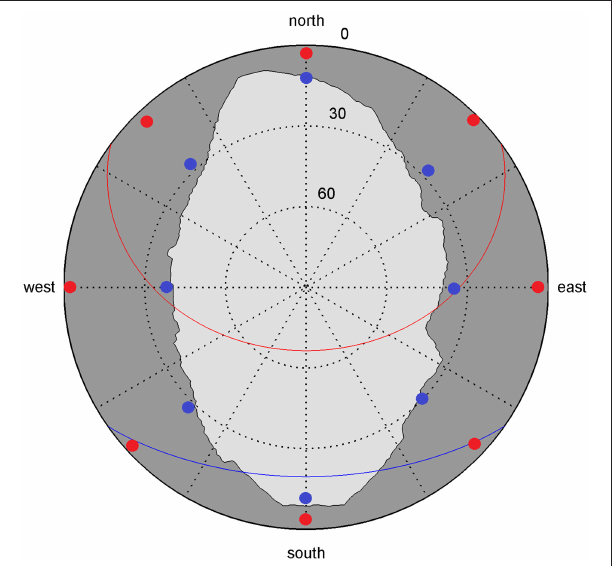
FIGURE 3 | Observed horizon (gray shaded area) and calculated local horizon angles (blue dots: without weighting, red dots: weighted) around the Alpine station St. Leonhard/Pitztal, Austria. Red and blue lines show the path of the sun at the winter (blue) and summer (red)